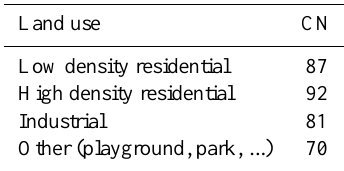
Table 2. Construction cost of different land uses.